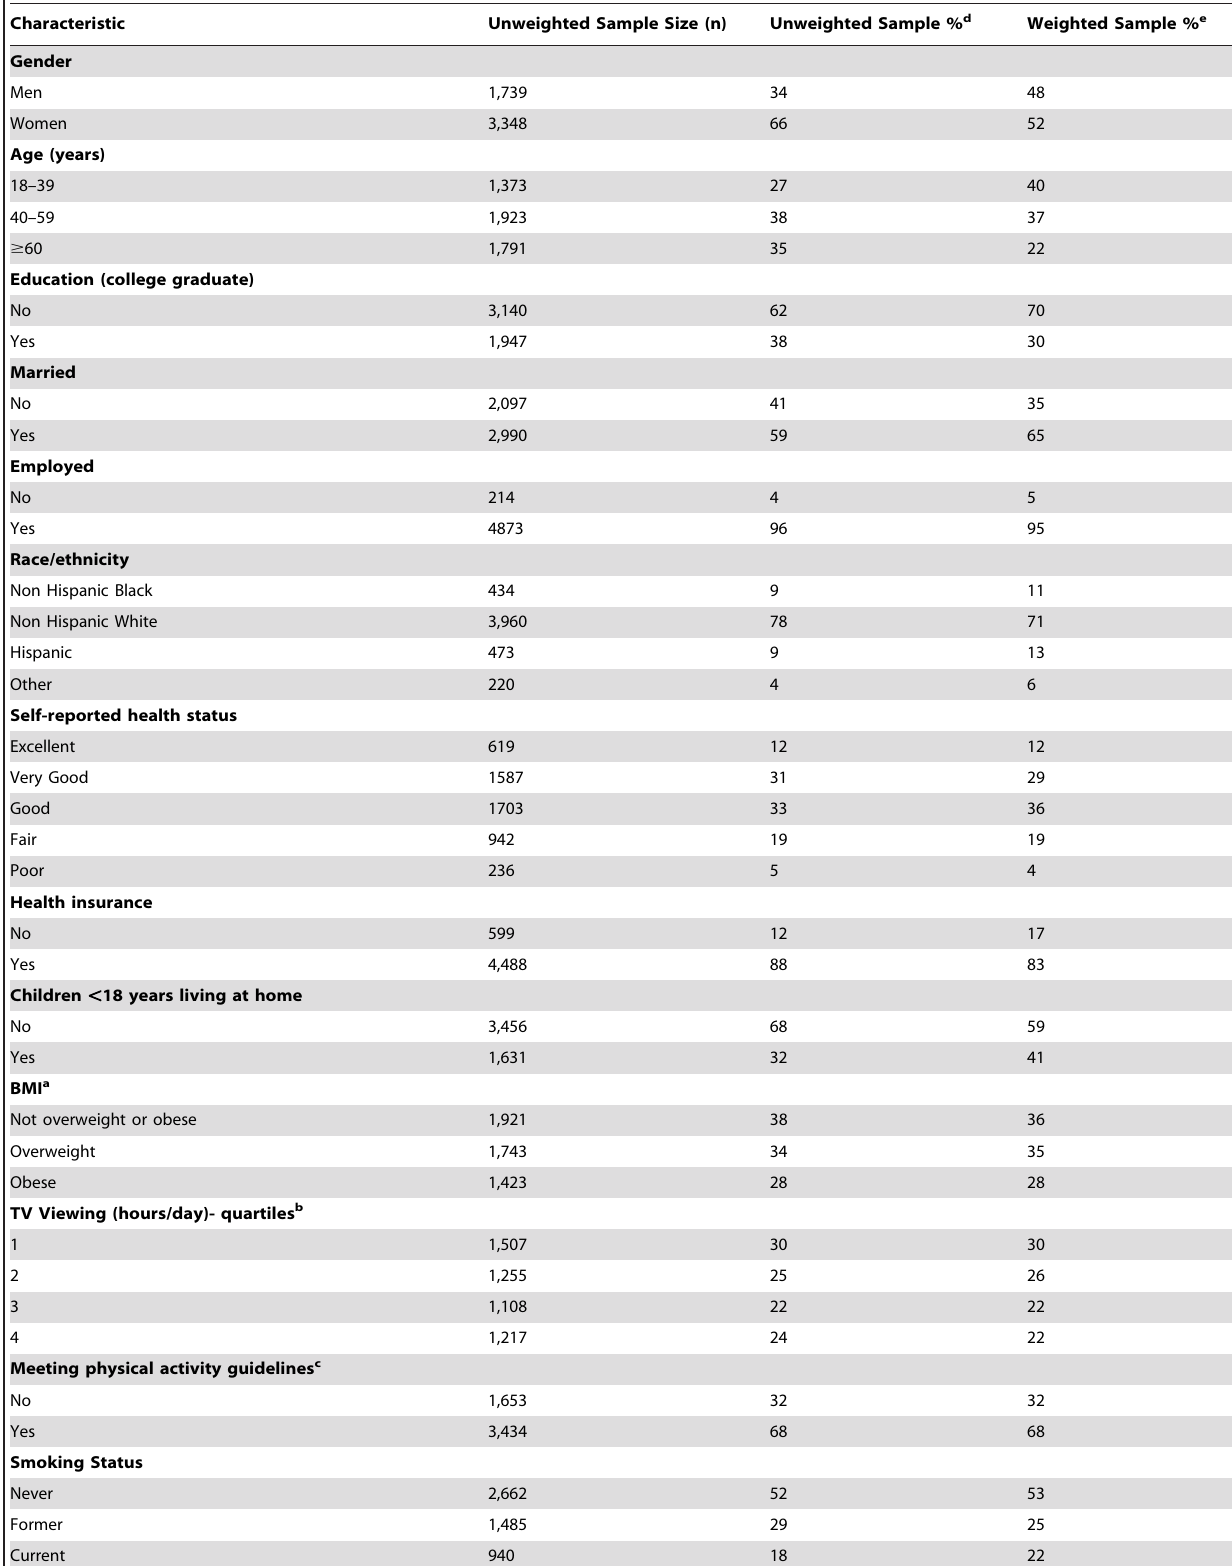
Table 1. Descriptive Characteristics of 2005 HINTS Analytic Sample (n